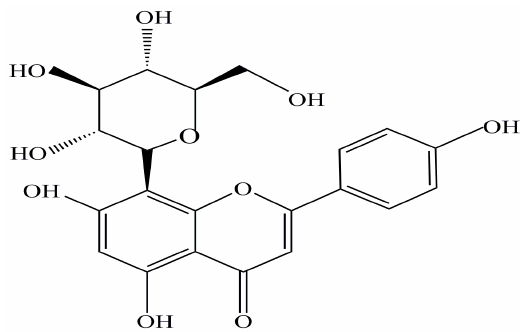
Figure 1. Chemical structural formula of vitexin.